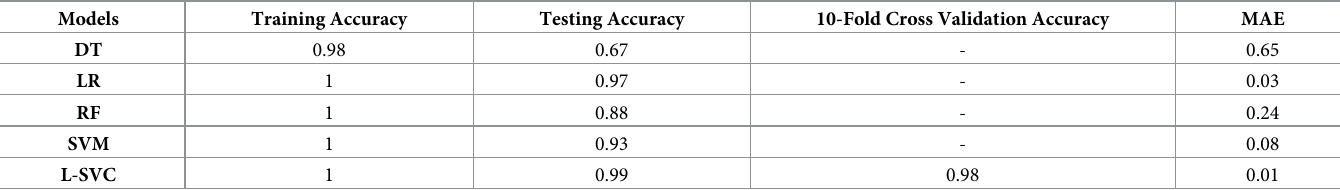
Table 8. Classification accuracy associated with error comparison between adopted L-SVC and benchmarked models.